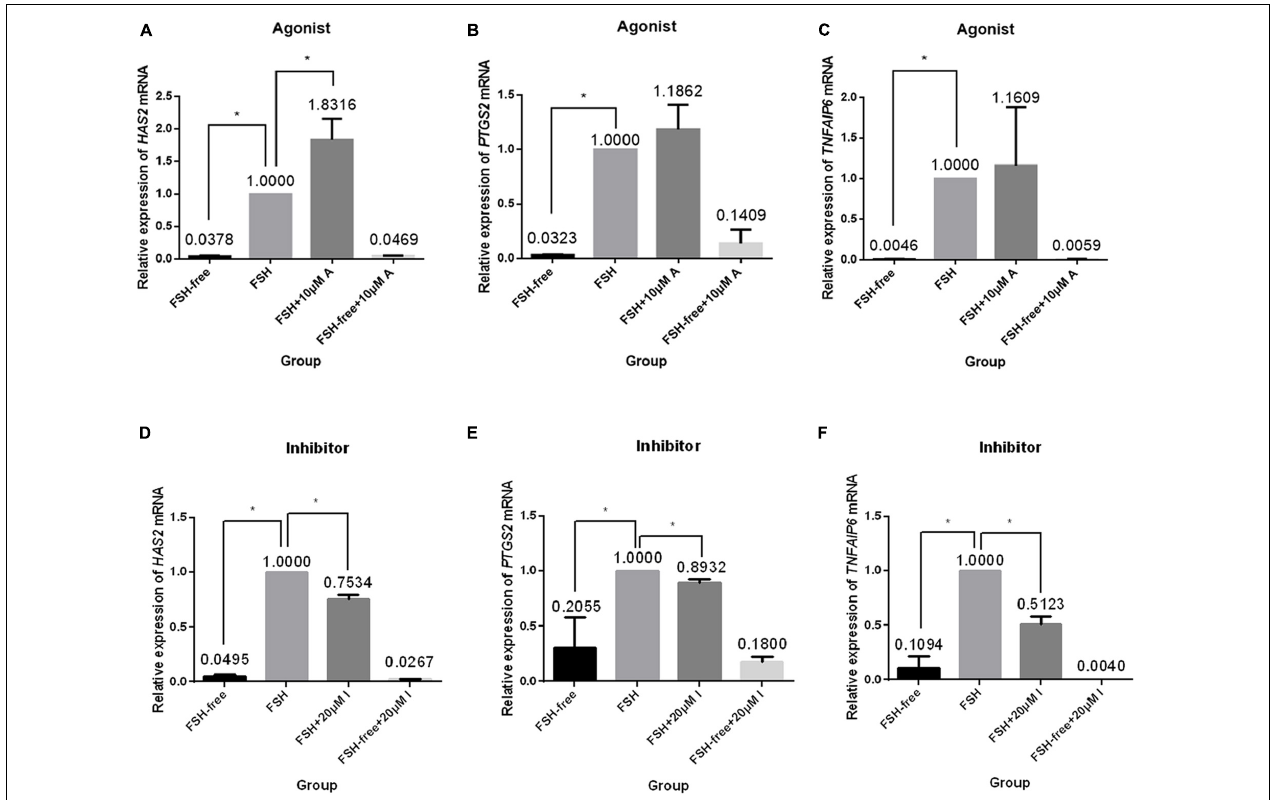
FIGURE 5 | Relative expression of genes related to cumulus cell expansion in porcine COCs cultured under different conditions. COCs were cultured in medium supplemented with the CASR agonist NPSR-568 (10 µ M, A–C ) or inhibitor NPS2390 (20 µ M, D–F ) in the presence or absence of FSH for 24 h. ACTIN mRNA was used as internal control. HAS2 : hyaluronan synthase 2; PTGS2: prostaglandin-endoperoxide synthase 2; TNFAIP6: tumor necrosis factor a-induced protein 6; CASR: Calcium-Sensing Receptor. The data represent means ± SEM (* p < 0.05) from at least two independent experiments. (*) indicates significance between groups; (ns) indicates no significance between groups. Significance was determined by Kruskal-Wallis test and Mann-Whitney U -test (A–C) or two-tailed t -tests (E,F)